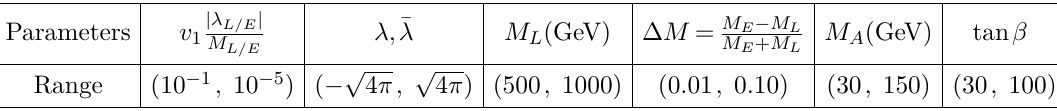
Table 2 . Range of the scanned parameters.